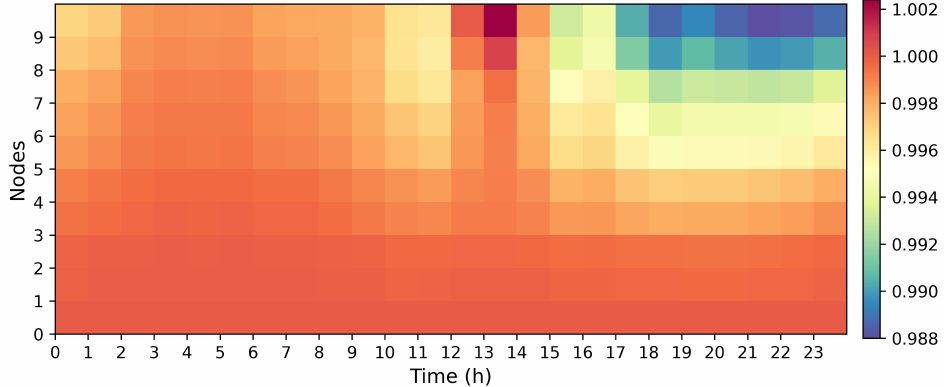
Figure 4. Nodes voltage results for the centralized